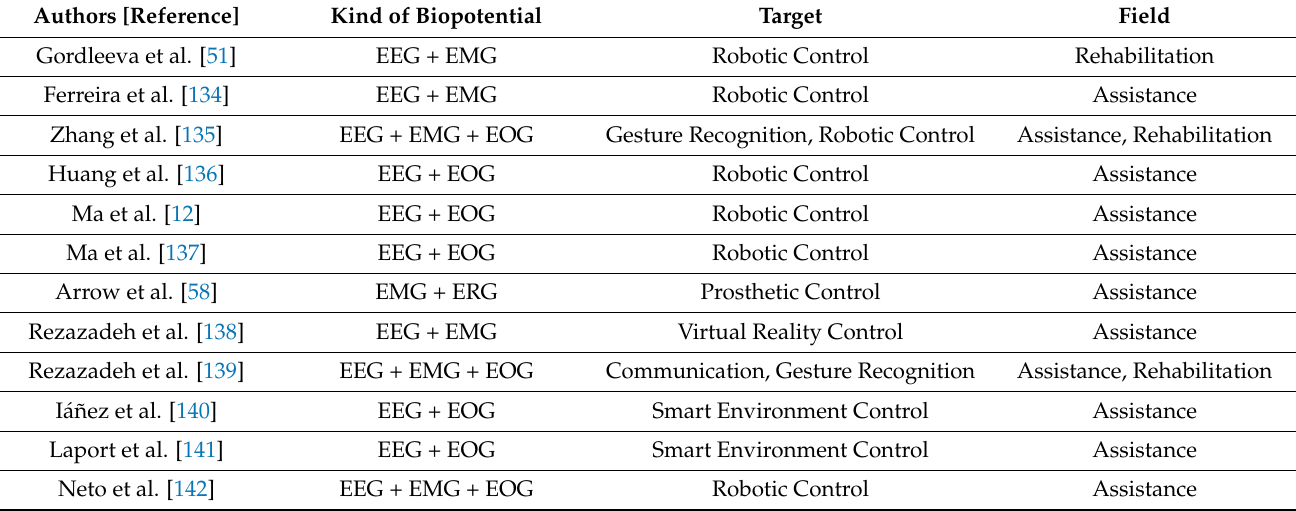
Table 6. Hybrid biopotential-based